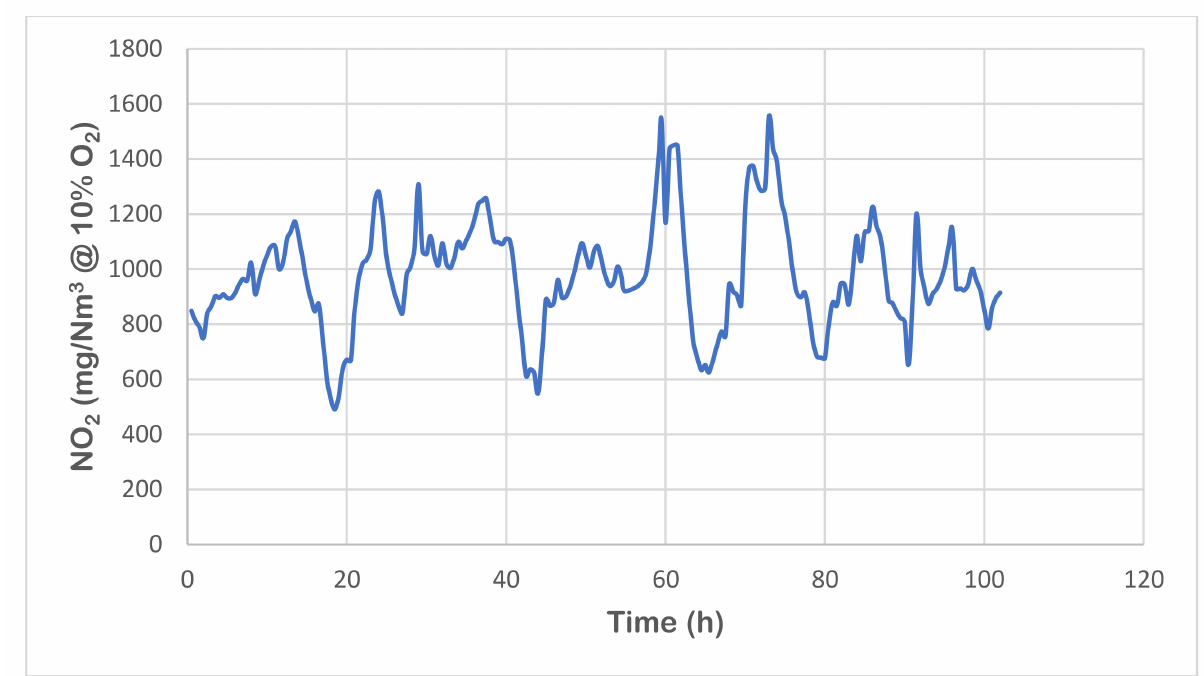
Figure 6. NO 2 pollutant concentration in flue gases during 100% pet-coke trial. NO x trial average is 980 mg/Nm 3 at 10% O 2 .